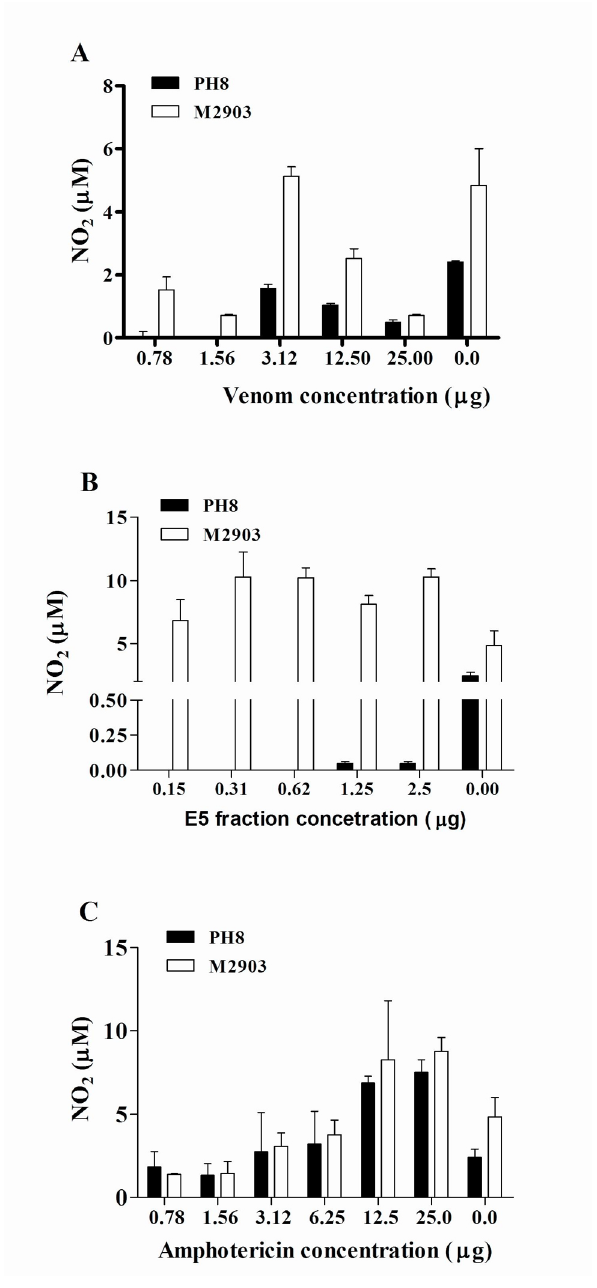
Figure 4. Effect of treatment on NO production by L. amazonensis (PH8) and L. braziliensis (M2903). NO levels were determined in supernatants from cultures of Leishmania treated with ( A ) B. moojeni crude venom, ( B ) B. moojeni venom E5 fraction and ( C ) amphotericin B, in different doses, or without treatment (medium). Columns shown nitrite (NO levels (means ± standard deviations from three independent experiments) expressed in